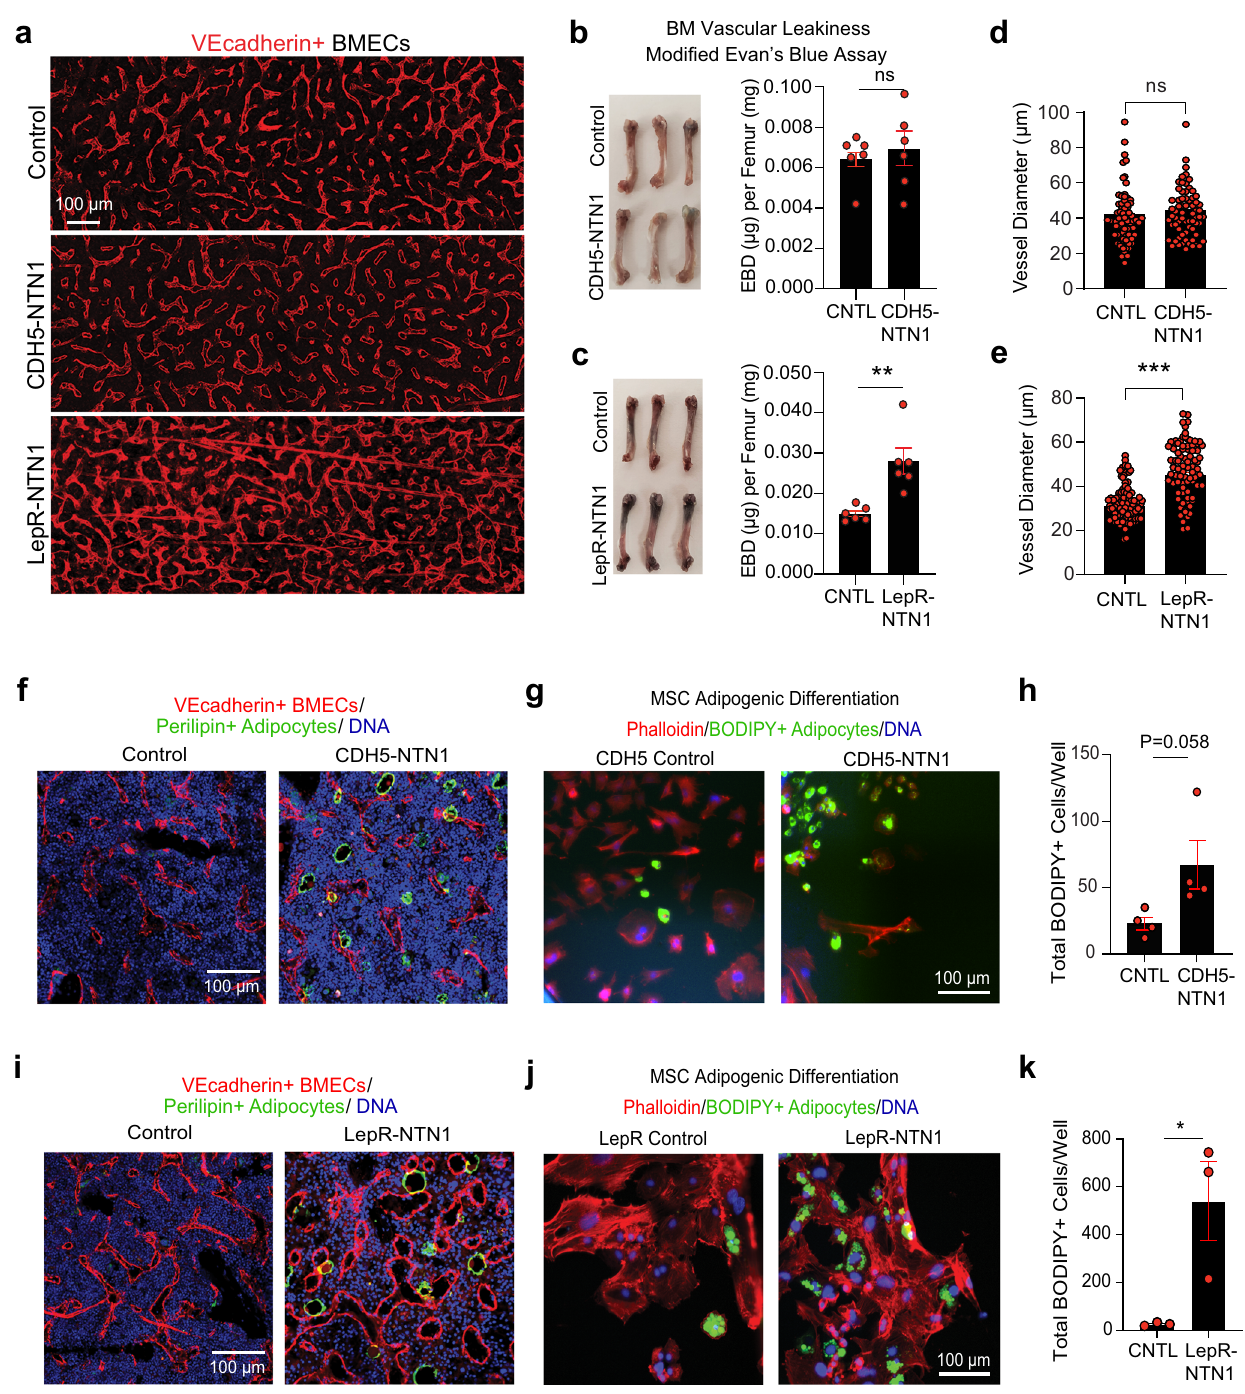
Fig.2|LossofNTN1inducesprematureagingphenotypeswithintheBMniche. a Representative immuno fl uorescence (IF) images of femurs intravitally-labeled with a vascular-speci fi c CD144/VEcadherin antibody (red) demonstrating vascular disruption in LepR-NTN1 mice (N=3 mice/group). b , c Representative images of femursisolatedfrommiceinjectedwithEvansBlueDye(EBD)andquanti fi cationof vascular leakiness by EBD extravasation in b CDH5-NTN1 mice, and c LepR-NTN1 mice ( n =6 mice/group). d , e Quanti fi cation of vessel diameter within the BM of d CDH5-NTN1 mice and e LepR-NTN1 mice ( n =3 mice/group). f , i Representative IF images of femurs stained with α -Perilipin1 (PLIN1) antibody demonstrating an